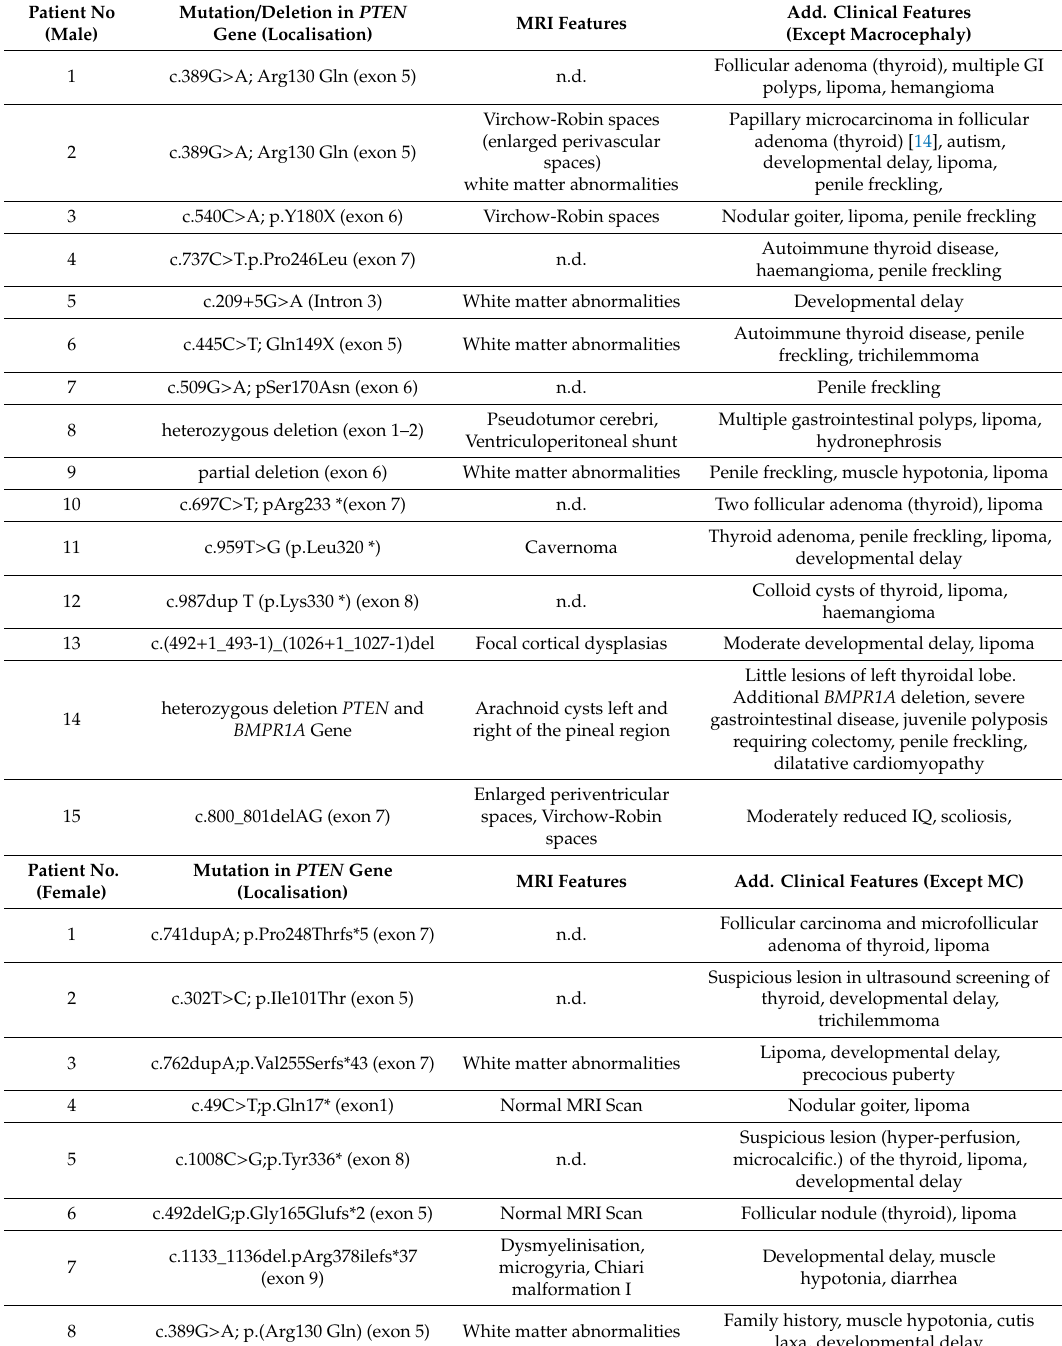
Table 2. Additional clinical characteristics, magnetic resonance imaging (MRI) features and molecular findings of pediatric PHTS patients. n.d. (not